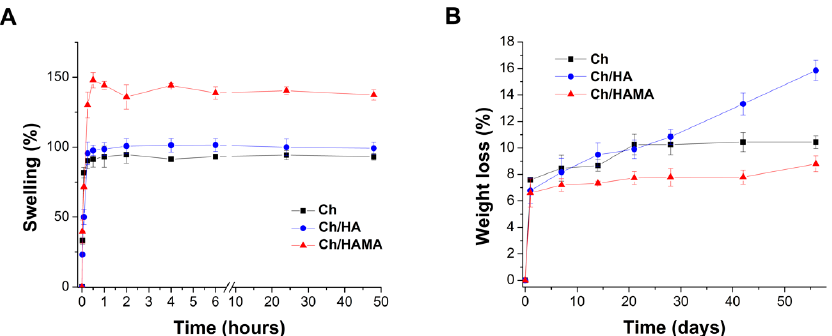
Figure 4. Effect of hydrogel membrane composition on swelling after incubation in PBS 7.4 at 37 °C for different periods of time ( A ). Weight loss of Ch, Ch/HA and Ch/HAMA membranes at different time points after soaking in PBS 7.4 at 37 °C under static conditions ( B ). Data represented the mean ± SD.